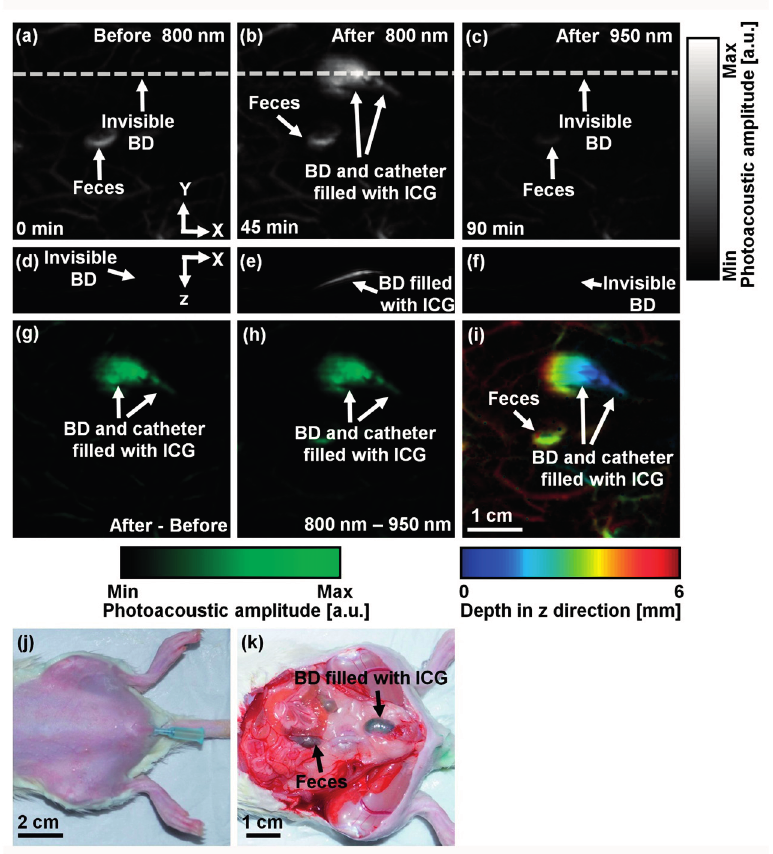
Figure 3. In vivo nonionizing and noninvasive photoacoustic (PA) cystography using indocyanine green (ICG). ( a ) Control PA MAP image of a rat’s abdomen at 800 nm acquired before ICG injection. Only surround blood vessels are visible; ( b ) PA MAP image at 800 nm after ICG injection displaying the bladder (BD) filled with ICG, catheter, and blood vessels; ( c ) PA MAP image at 950 nm after ICG injection. The bladder disappeared due to the spectral response of ICG; ( d – f ) Depth-sensitive B-mode PA images of (a–c) cut along the dotted lines; ( g ) PA differential MAP image between (a) and (b); ( h ) PA differential MAP image between (b) and (c); ( i ) Depth-sensitive pseudo-colored PA MAP image of (b); ( j ) Photograph taken before PA imaging; ( k ) Photograph taken after PA imaging and skin